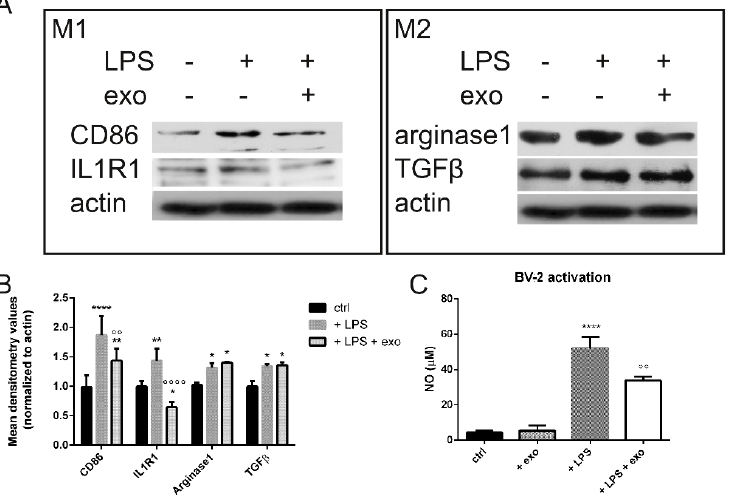
Figure 2. M1 and M2 microglia switch. ( A ) WB analysis of markers of M1 and M2 phenotypes in presence or absence of LPS and exo (24 h). ( B ) The graph represents the mean ± SD of densitometric analysis of 3 experiments, normalized to actin values. CD86: **** p -value < 0.0001; ** p = 0.003; ◦◦ p = 0.004. IL1R1: * p -value = 0.021; ** p = 0.004; ◦◦◦◦ p -value < 0.0001. Arginase1: + LPS * p = 0.046; + LPS + exo * p = 0.013. TGF β : + LPS * p = 0.024; + LPS + exo * p = 0.018. ( C ) Graph showing changes in NO production. ◦◦ p -value = 0.001; **** p -value <